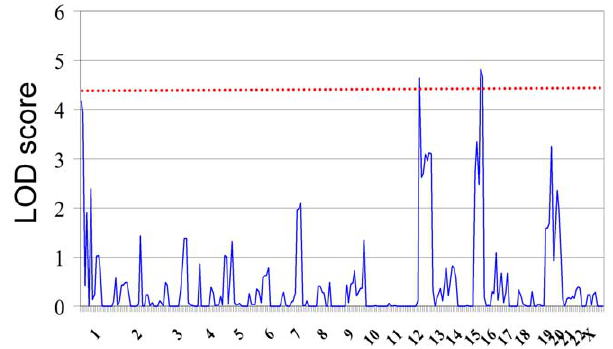
Figure 2. Two significant and two suggestive LOD scores on Hsa12, Hsa15, Hsa1, and Hsa19. LOD scores of genome-wide linkage analyses using the CEPH-HapMap family-cohort of three generations are plotted for all autosomal chromosomes (in blue). The blue line shows the maximal LOD score within a window size of 10 kb. The red dotted line indicates the significance level identified through 1’000 simulations.